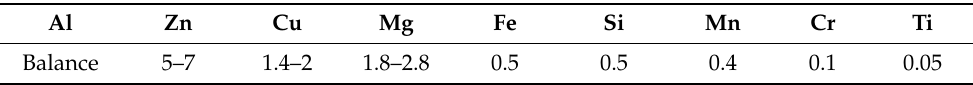
Table 2. Chemical composition of AA7075 substrate